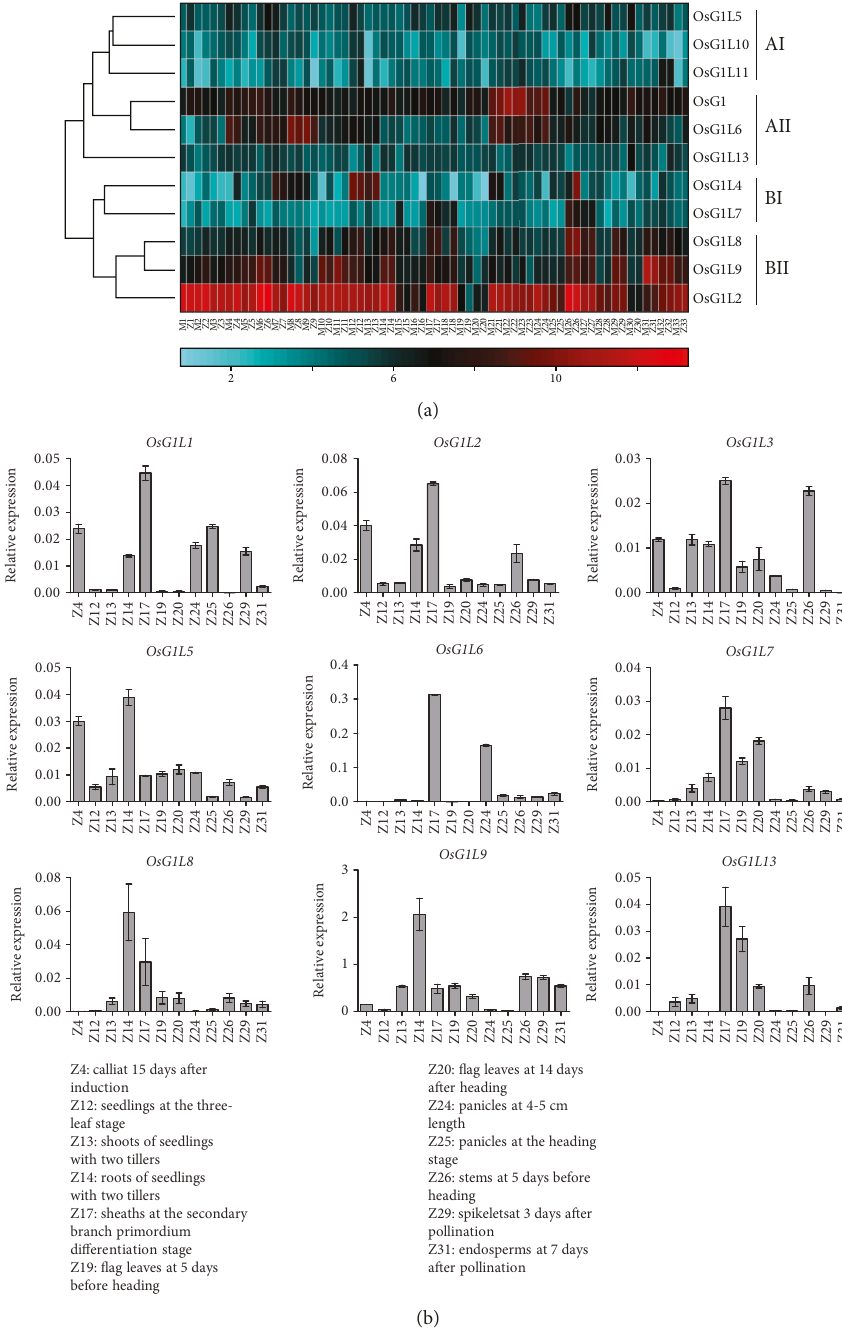
Figure 4: Genome-wide expression pro fi les and qRT-PCR analysis of OsG1 / G1Ls . (a) The hierarchical clustering displays the expression pro fi les of the 11 OsG1 / G1Ls using the matching probes in the A ff ymetrix microarray. The color scale at the left bottom represents the log -transformed expression values. Cyan indicates a low expression level, black indicates a medium expression level, and red indicates a 2 high expression level. The thirty-three samples of MH63 and ZS97 were sequentially marked as M1 to M33 and Z1 to Z33 on the x -axis, respectively. The detailed sample information was listed in Supplementary Table S1. (b) qRT-PCR analysis of 9 OsG1 / G1Ls . The twelve analyzed samples were indicated as Z4 to Z31 on the x -axis because they were sampled according to the tissues and developmental stages in the microarray (see Supplementary Table S1). The values on the y -axis represent the relative expression levels. The error bars represent the standard deviation of the means of three independent